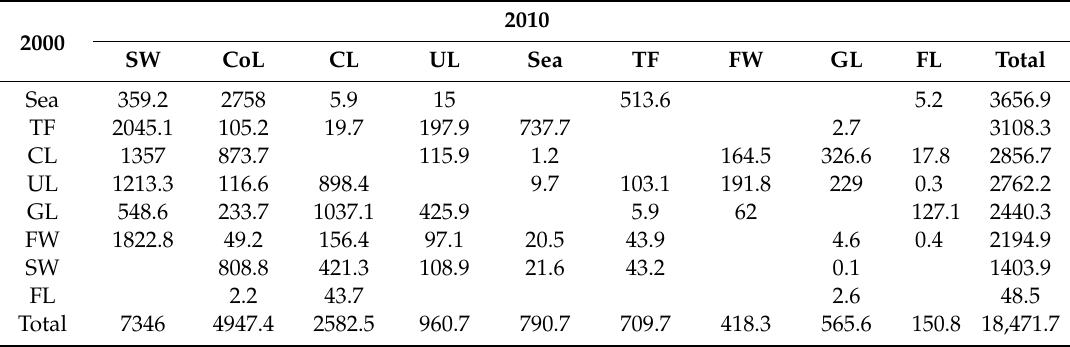
Table 5. Land use transformation matrix, 2000–2010 (in